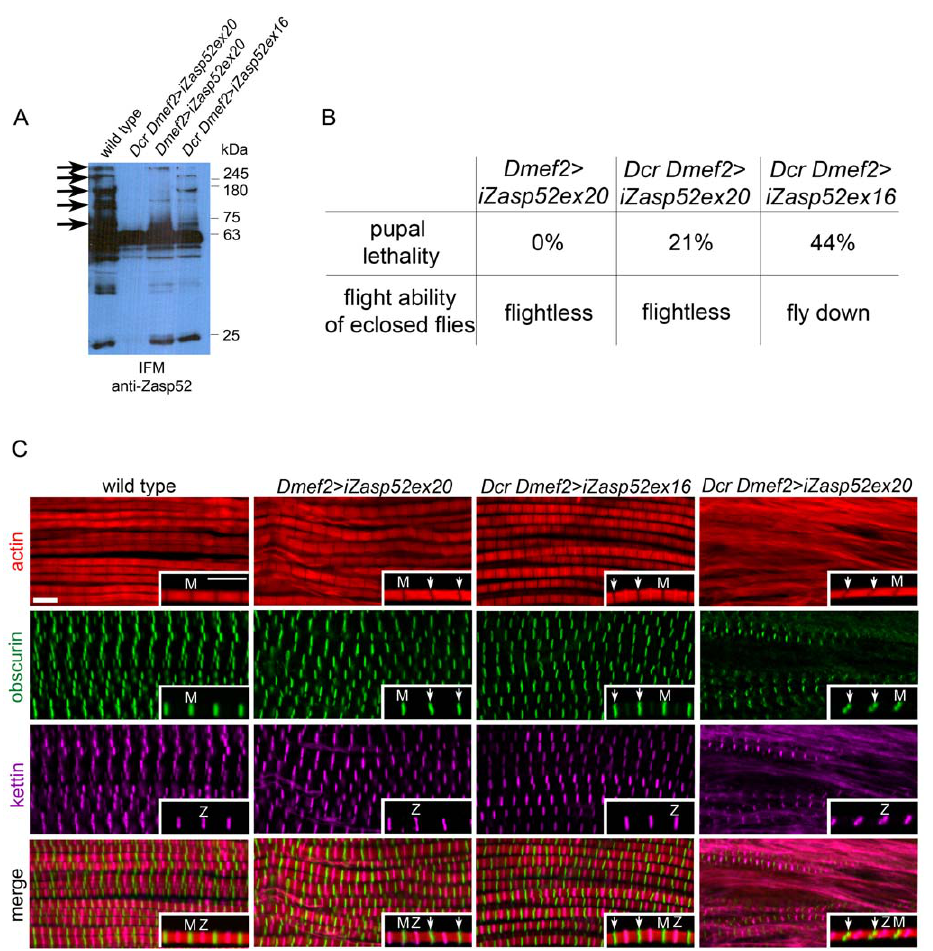
Figure 3. Depleting long isoforms of Zasp52 affects IFM structure. (A) Immunoblot of isolated IFMs from wild type and Zasp52 knockdown flies incubated with anti-Zasp52 antibody. Long Zasp isoforms are reduced in Dmef2 . iZasp52ex20 flies and are absent in Dcr Dmef2 . iZasp52ex20 flies. In Dcr Dmef2 . iZasp52ex16 flies, long isoforms are reduced to a smaller degree compared to the other mutant genotypes. Arrows indicate several prominent depleted isoforms. (B) Pupal lethality and flight defects of wild type and iZasp52 knockdown flies. Pupal lethality is higher in Dcr Dmef2 . iZasp52ex16 flies than in Dmef2 . iZasp52ex20 and Dcr Dmef2 . iZasp52ex20 flies. Dmef2 . iZasp52ex20 flies are flightless, whereas Dcr Dmef2 . iZasp52ex16 flies are flight impaired. (C) Adult IFM myofibrils of wild type and iZasp52 knockdown flies stained with phalloidin (red), anti- obscurin (green), and anti-kettin (magenta) antibody. Inserts show single myofibrils at higher magnification. Obscurin serves as an M-line and kettin as a Z-disc marker. In the wild type, H-zones are visible as straight dark lines. Obscurin and kettin label as straight bands in an alternating pattern at the Z-disc and M-line. In Dmef2 . iZasp52ex20 flies, H-zones are occasionally bent and obscurin labels in wavy stripes (arrowheads). Frayed myofibrils are visible. Dmef2 . iZasp52ex16 myofibrils also show distorted H-zones and wavy obscurin labeling. In Dcr Dmef2 . iZasp52ex20 IFM, myofibrils are frequently frayed, H-zones are severely distorted, and obscurin and kettin labeling is abnormal. Scale Bar, 5 m m.